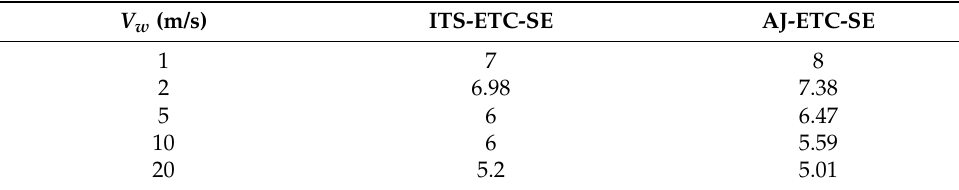
Table 7. Iteration numbers of different algorithms under different wind velocities.